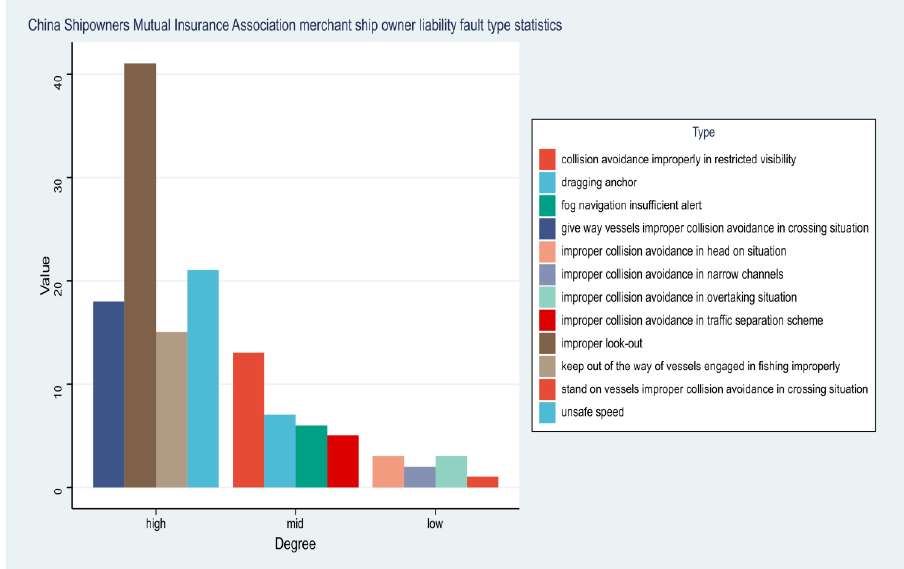
Figure 1. China Shipowners Mutual Insurance Association merchant ship owner liability fault type statistics.